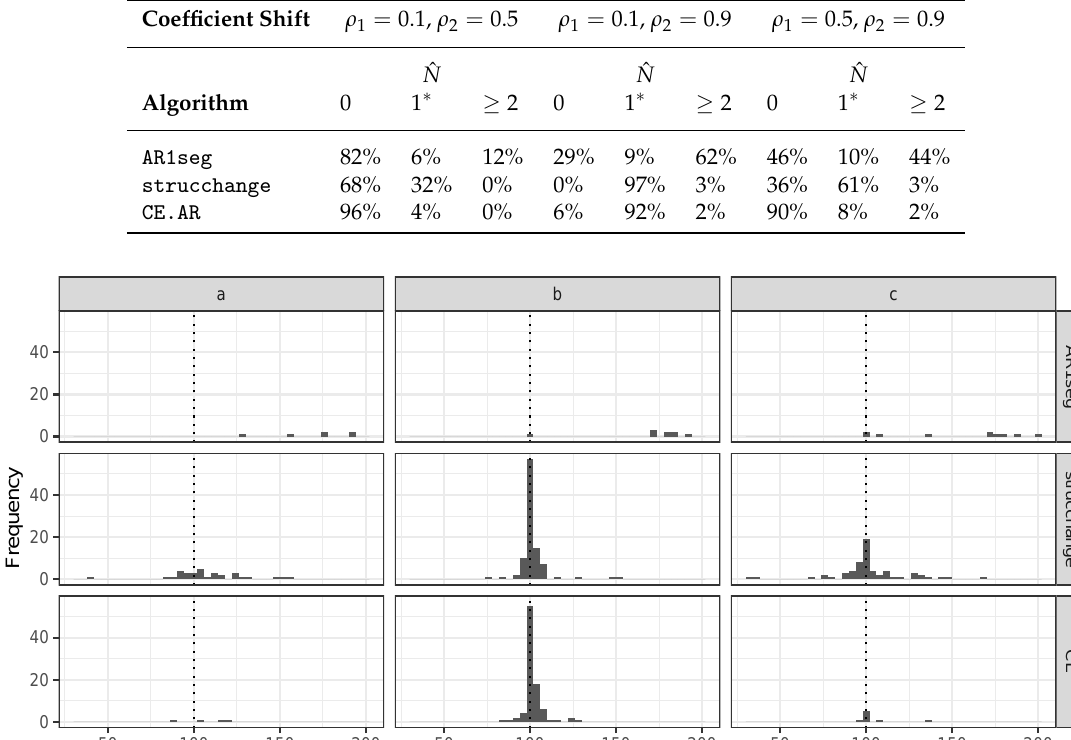
Figure 4. Under scenario 2, frequency of the estimated locations was filtered by the correct number of change-points; the true change-point number was 100. ( a ) The results under ρ 1 = 0.1, ρ 2 = 0.5. ( b ) The results under ρ 1 = 0.1, ρ 2 = 0.9. ( c ) The results under ρ 1 = 0.5, ρ 2 = 0.9.